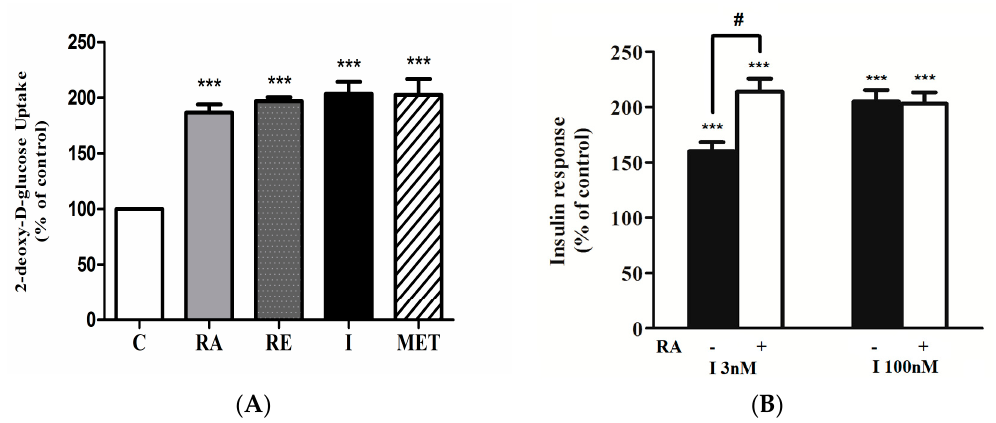
Figure 3. ( A ) Effects of rosmarinic acid (RA), rosemary extract (RE), insulin (I) and metformin (MET) on glucose uptake. Serum-deprived L6 myotubes were incubated without (control, C) or with 5 µM RA (4 h), 5 µg/mL RE (4 h), 100 nM I (0.5 h) or 2 mM MET (2 h) followed by 2-deoxy- D -glucose uptake measurements. Results are the mean ± SE of 5 independent experiments. *** p < 0.001, vs control. ( B ) Effect of rosmarinic acid (RA) on insulin-stimulated glucose uptake. Serum-deprived L6 myotubes were incubated without or with 5 µM RA (4 h) followed by stimulation with 3 nM or 100 nM insulin for 0.5 h and glucose uptake measurements. Results are the mean ± SE of 3–4 independent experiments. *** p < 0.001, vs control, # p < 0.05 vs insulin alone.